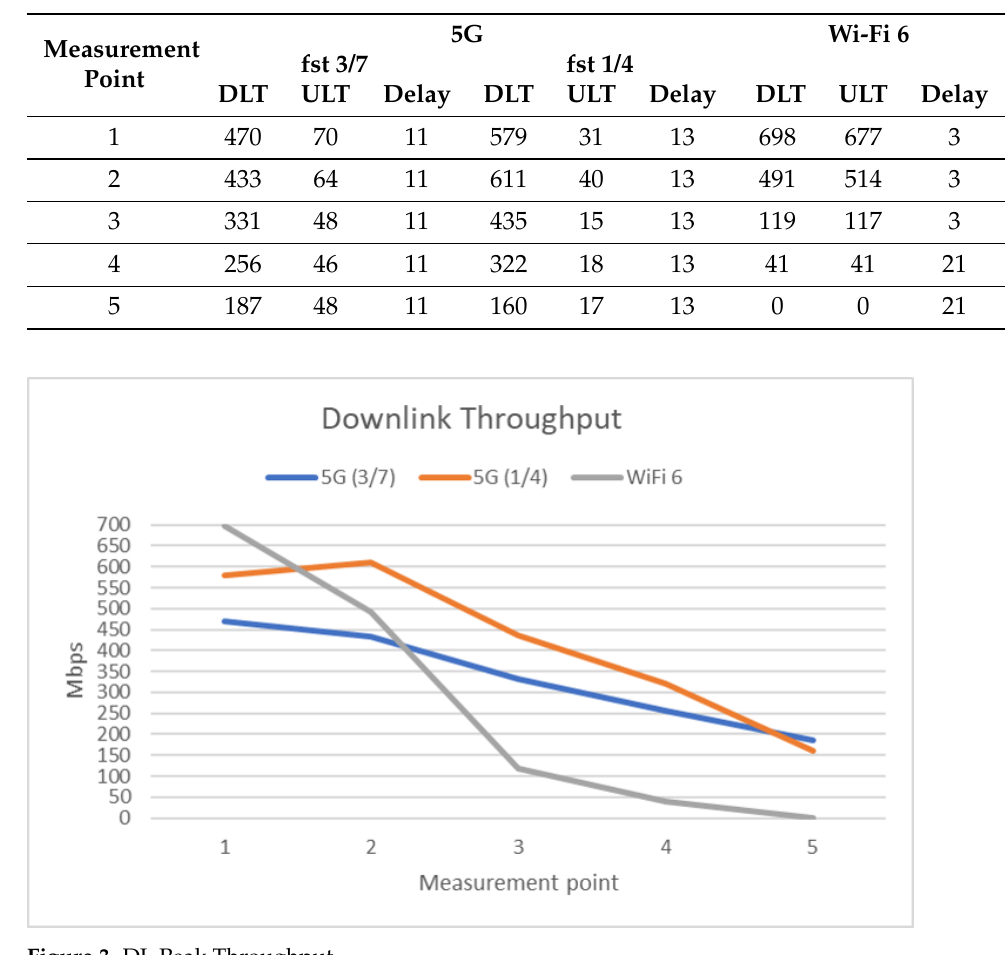
Figure 3. DL Peak